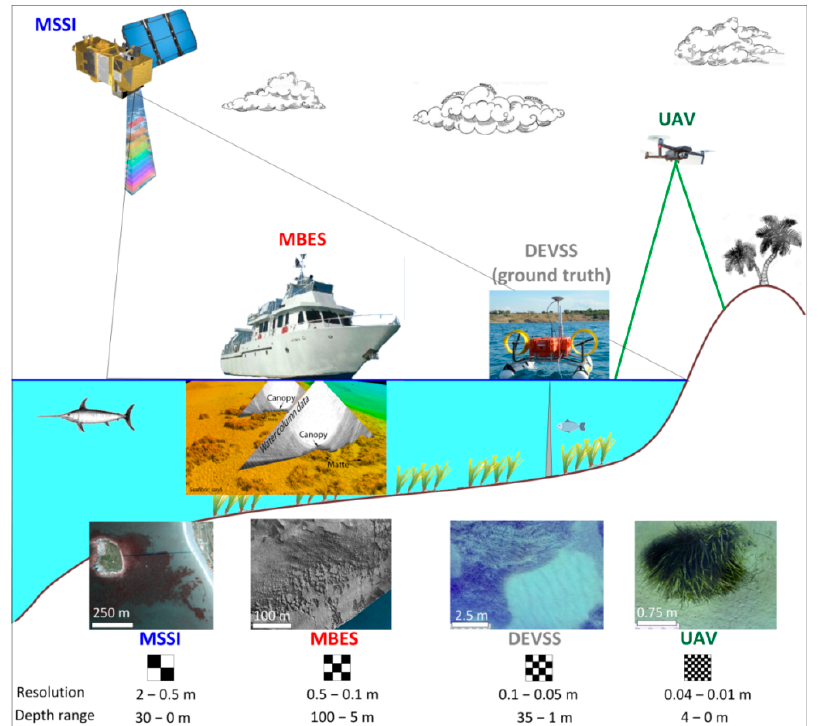
Figure 2. Diagram and comparison between different data sources and their resolution at the seafloor, for seabed and habitat mapping: Multispectral Satellite Image (MSSI); High-resolution Multibeam Echo-Sounder System (MBES); Development Vehicle for Scientific Survey (DEVSS); Unmanned Aerial Vehicle (UAV).